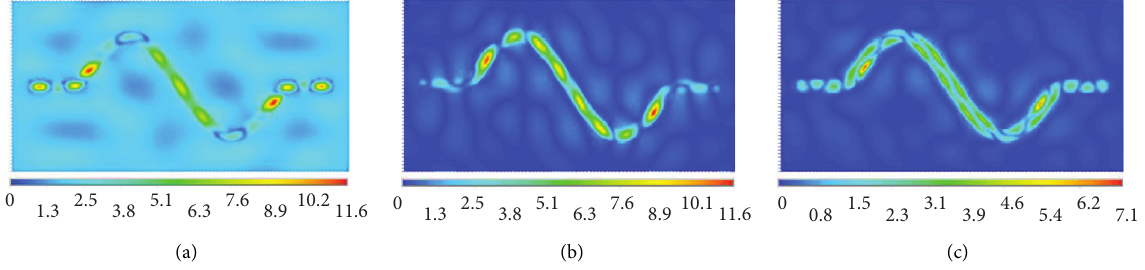
� 300m/s, f � 1.5Hz, H � 100m, and NR � 2). Top view displacement cloud view (a) u s